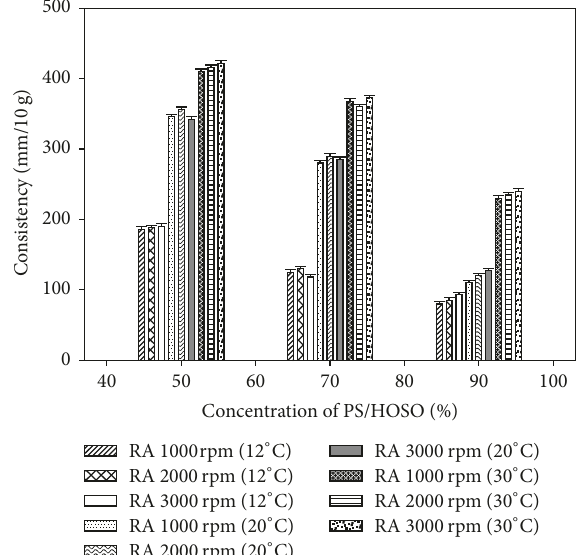
Figure 1: Effect of PS/HOSO (palm stearin and high oleic safflower oil) blends and rate of agitation (ra) on the consistency of zero-trans crystallized fats equilibrated at three storage